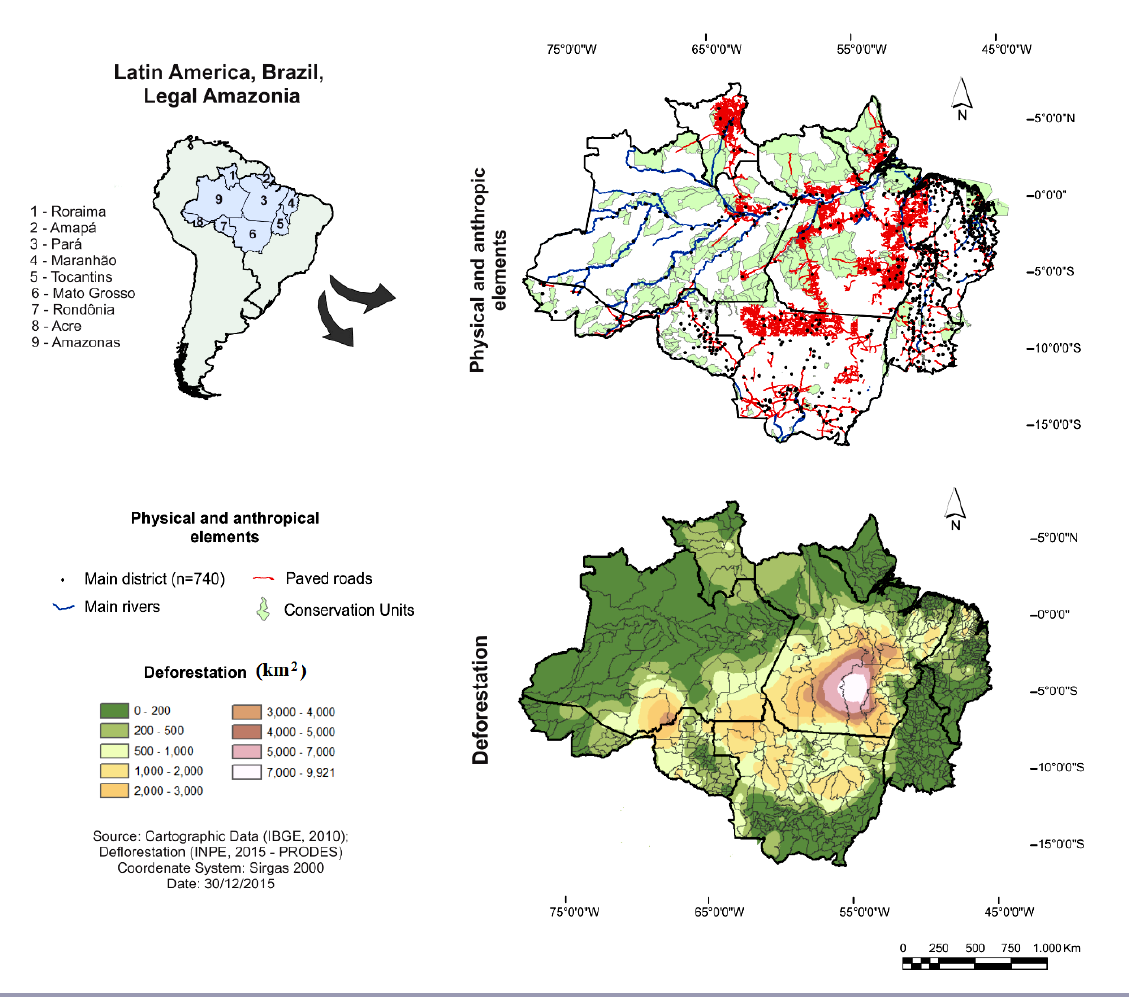
Fig. 1. Main physical and anthropological elements and accumulated deforestation (km²) between 2001 and 2010 in the Brazilian